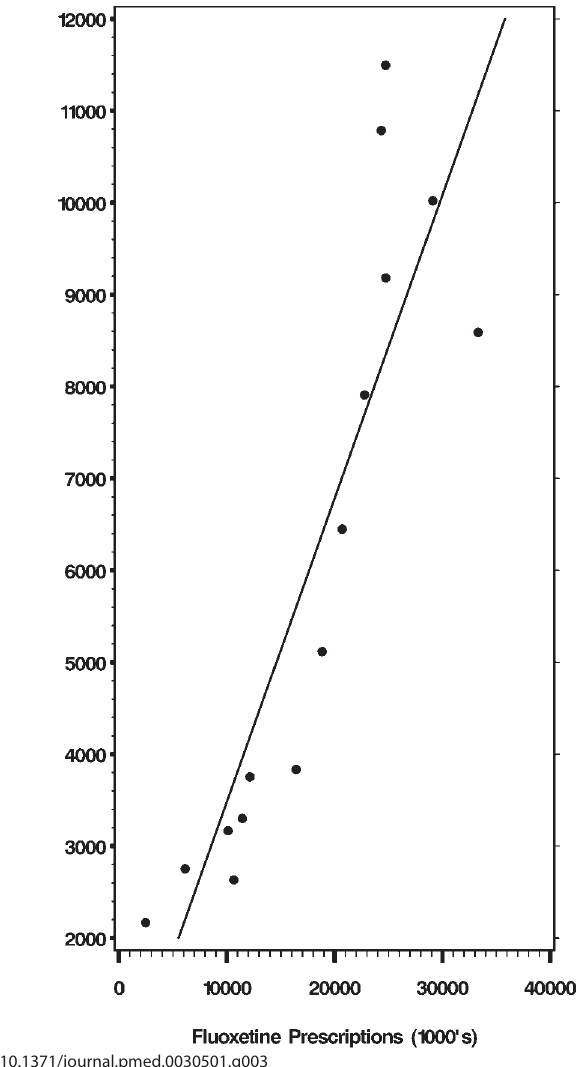
Figure 3. Correlation between Fluoxetine Prescriptions and the Dow Jones